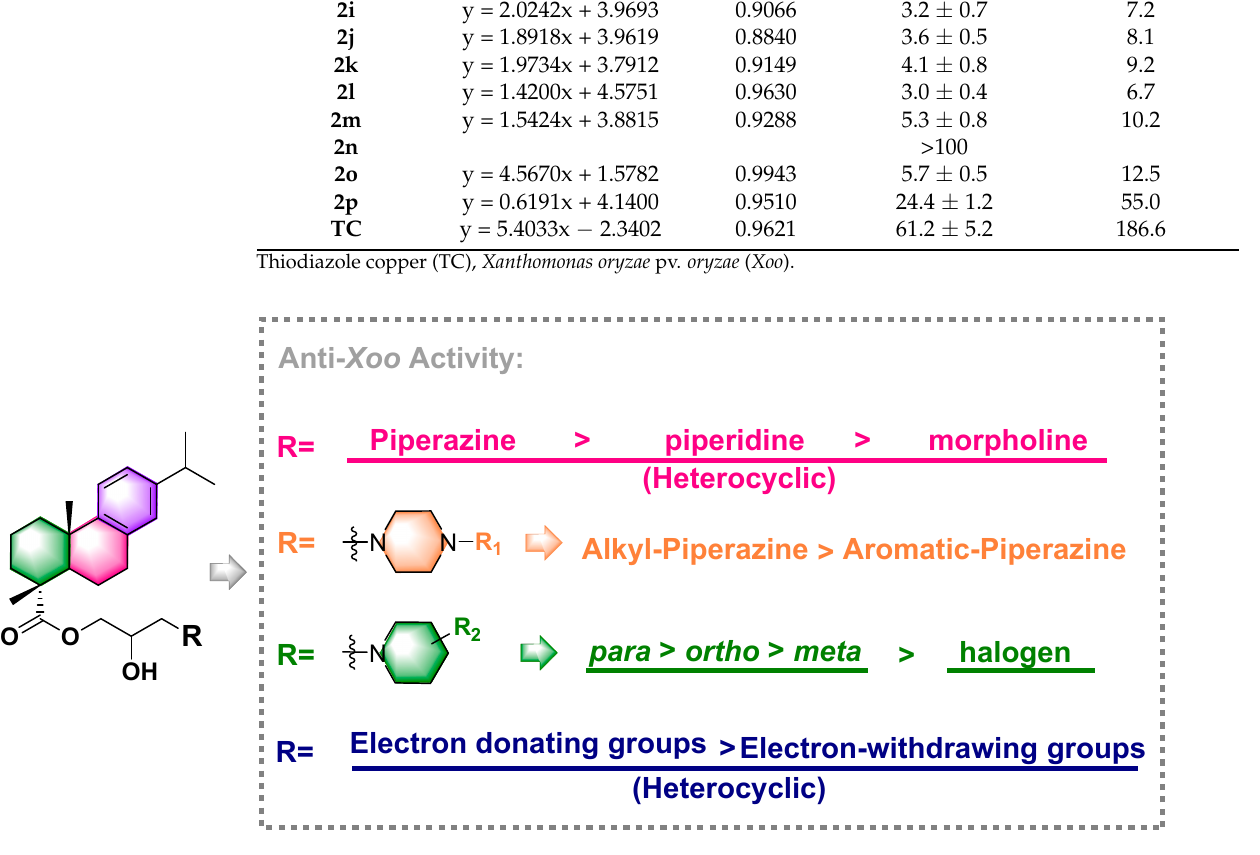
Figure 3. Overall structure-activity relationship analysis of all target compounds.